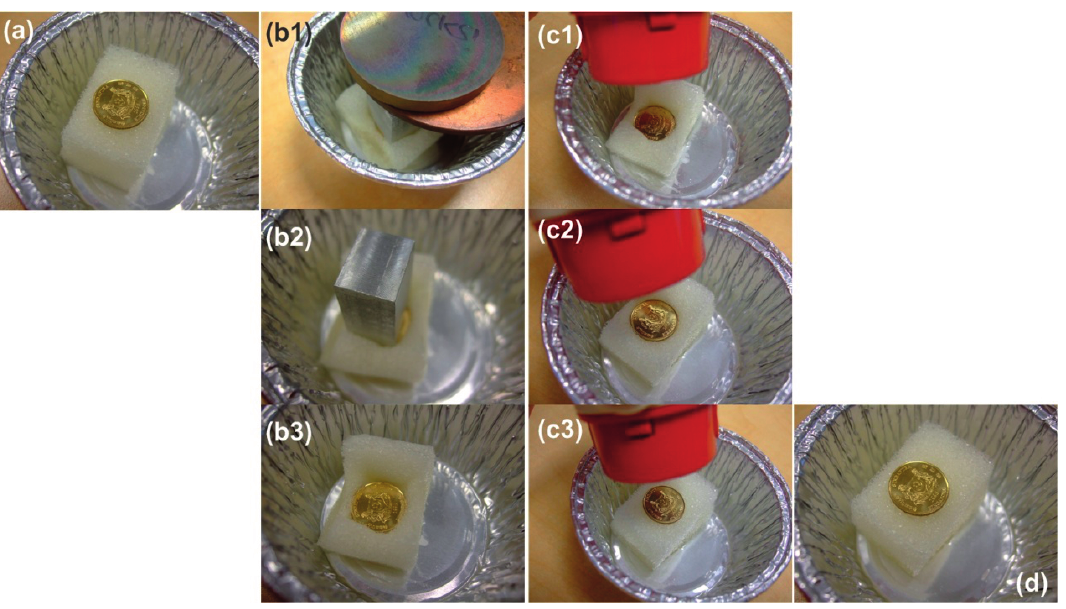
Figure 5. The SME in sponge-wax hybrid. ( a ) Original shape; ( b1 ) indented at high temperatures using a coin; ( b2 ) cooling in air; ( b3 ) removal of constraint; ( c1 – c3 ) upon heating using a hair dryer; and ( d ) after heating.